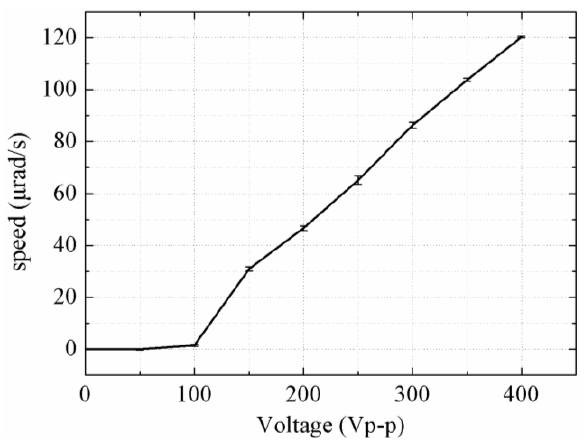
Figure 9. Plot of the speed versus the input voltage.